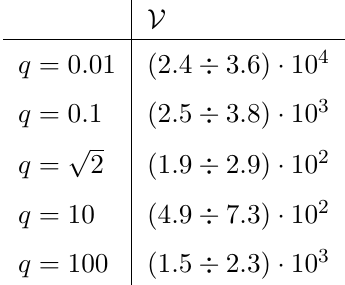
Table 4 . Overall volume of the extra-dimensions for different values of q . The range of q values was chosen so that both τ and τ get stabilised at values (cid:29) 1 , in accordance with instanton expansion b f and EFT